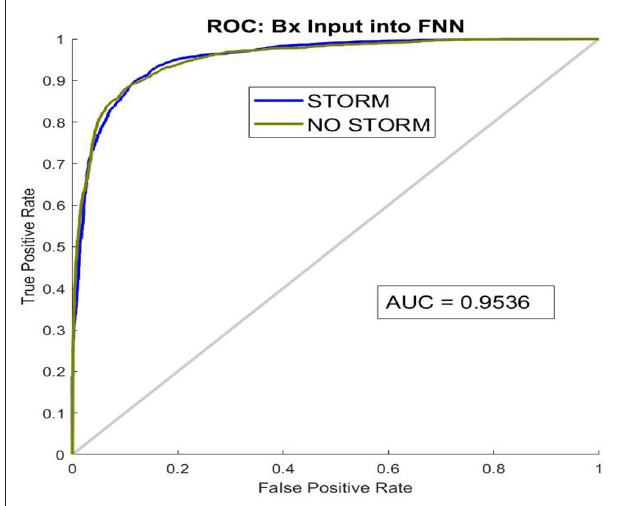
TABLE 5 | Experiment 1: FNN 1 using B z